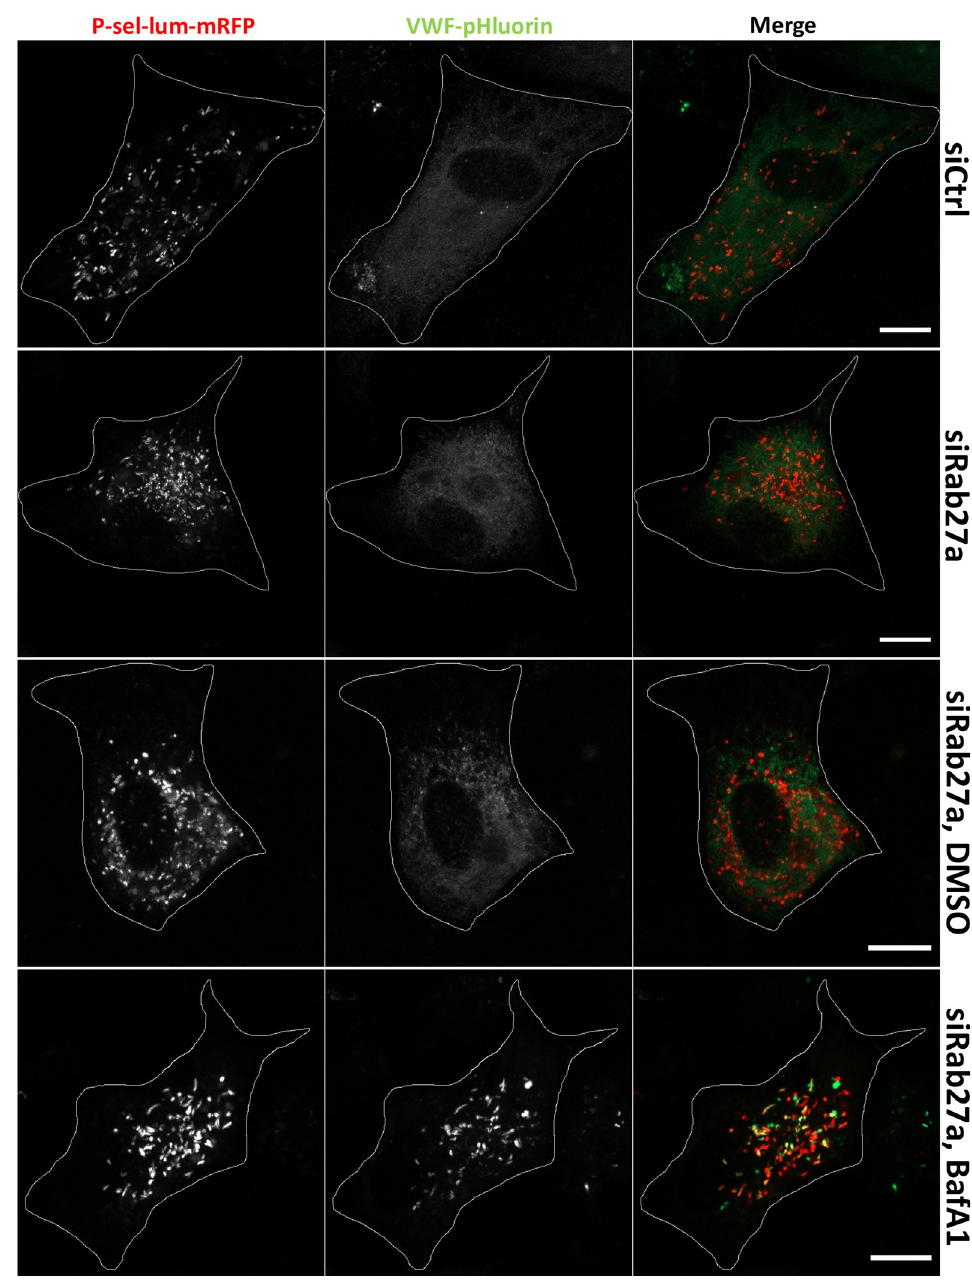
Fig 5. Rab27a is not involved in acidification of WPB. HUVEC were transfected with untargeting siRNA (siControl) or siRNA directed against Rab27a, both together with P-sel-lum-mRFP and VWF-pHluorin. After 24 h, cells were analyzed directly via confocal live cell microscopy or incubated with 0.1% DMSO or 250 nM BafA1, respectively, at 37˚C for 2 h followed by live cell imaging. Shown are images of maximum intensity projections of z-stacks. Cell circumferences are indicated by lines. Scale bars: 10 μ